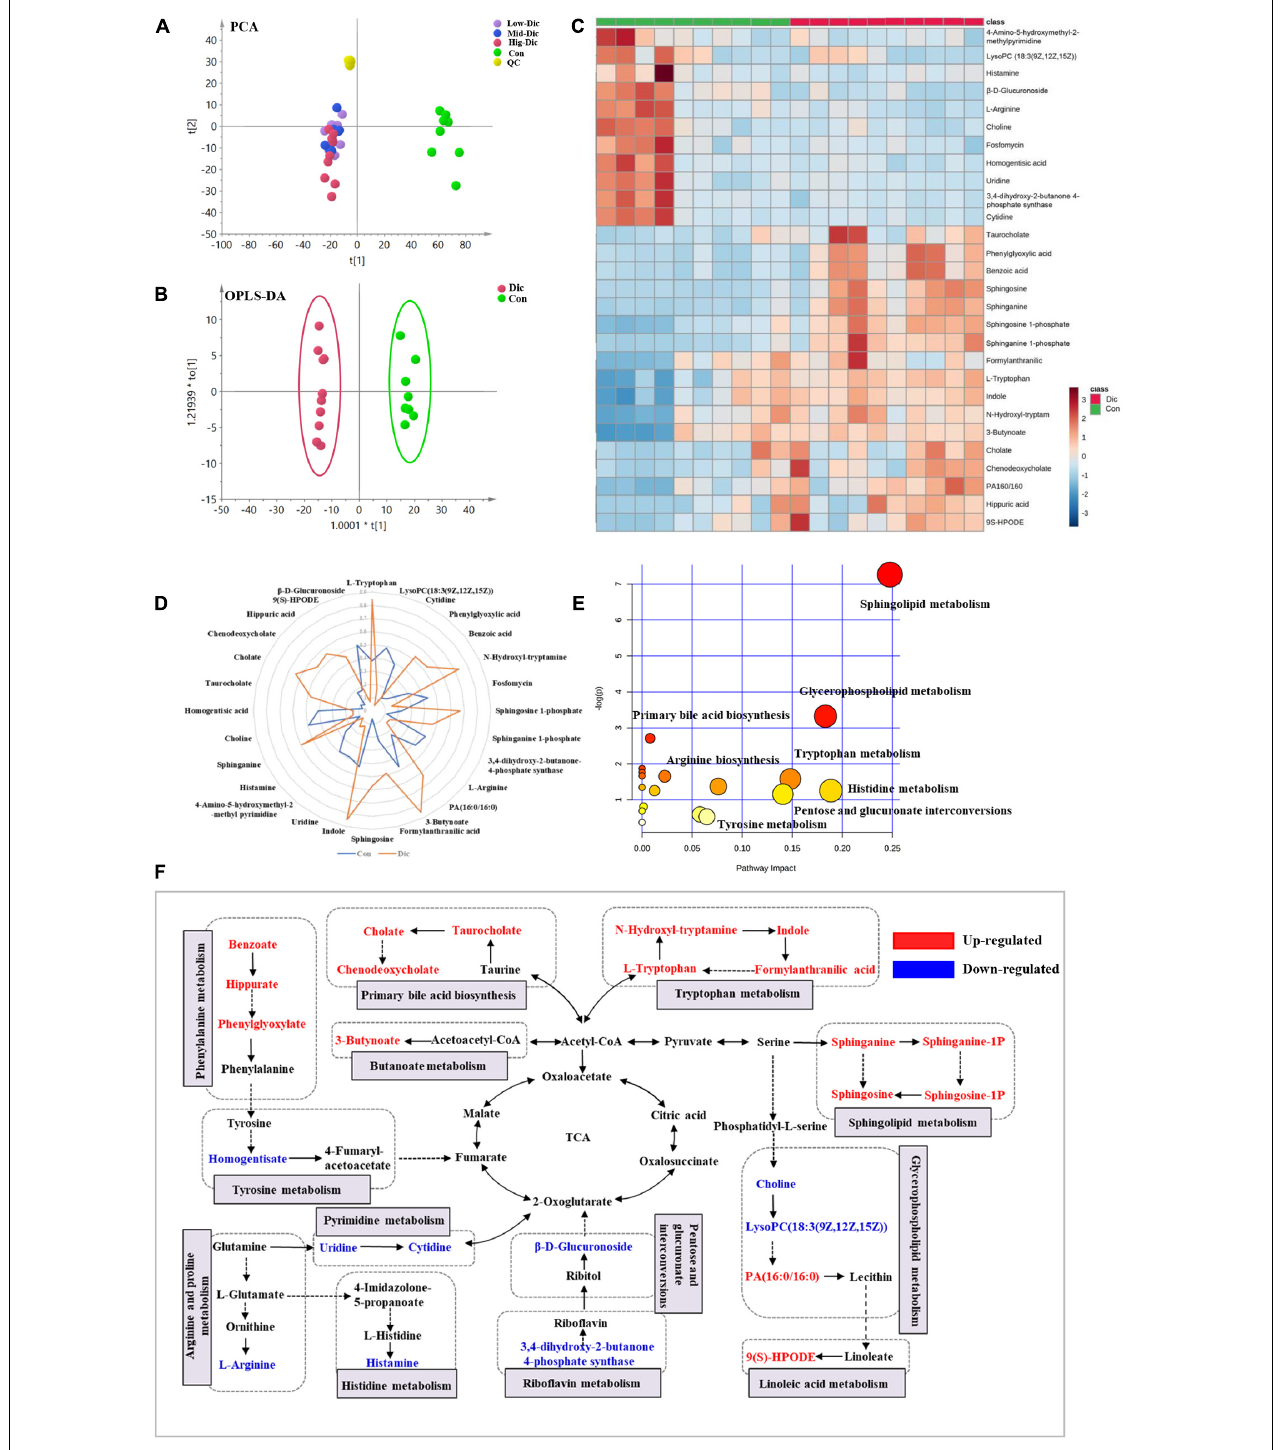
FIGURE 3 | Metabolomic analysis of dictamnine-induced hepatotoxicity in mice. (A) PCA score plot for all groups female mice in ESI modes. (B) OPLS-DA score plot for experimental groups (Con vs. Dic). (C) Clustered heat map of the significantly differentially expressed metabolites between dictamnine-treated mice and untreated control. The colors from blue to red indicate the relative contents of metabolites. (D) A spider plot of 28 differentially expressed metabolites between Con vs. Dic groups. The blue line represents the control group, and the orange line represents Dic group. (E) Schematic diagram of the altered metabolic pathways. (F) Network map of metabolic pathways and metabolites in dictamnine treated and untreated control mice. Metabolites in red increased, and metabolites in blue decreased.